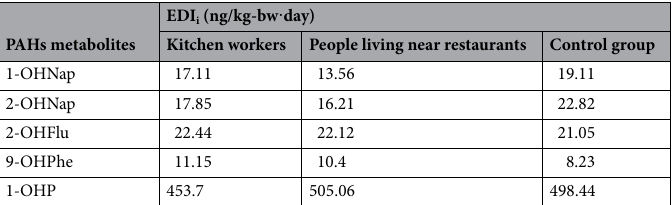
Table 4. EDI i for PAHs metabolites measured in the studied